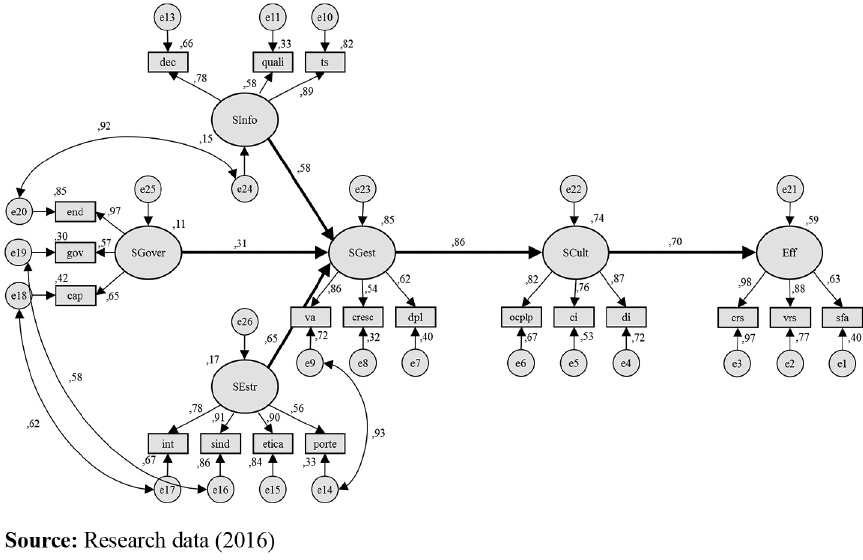
Figure 3. SEM results